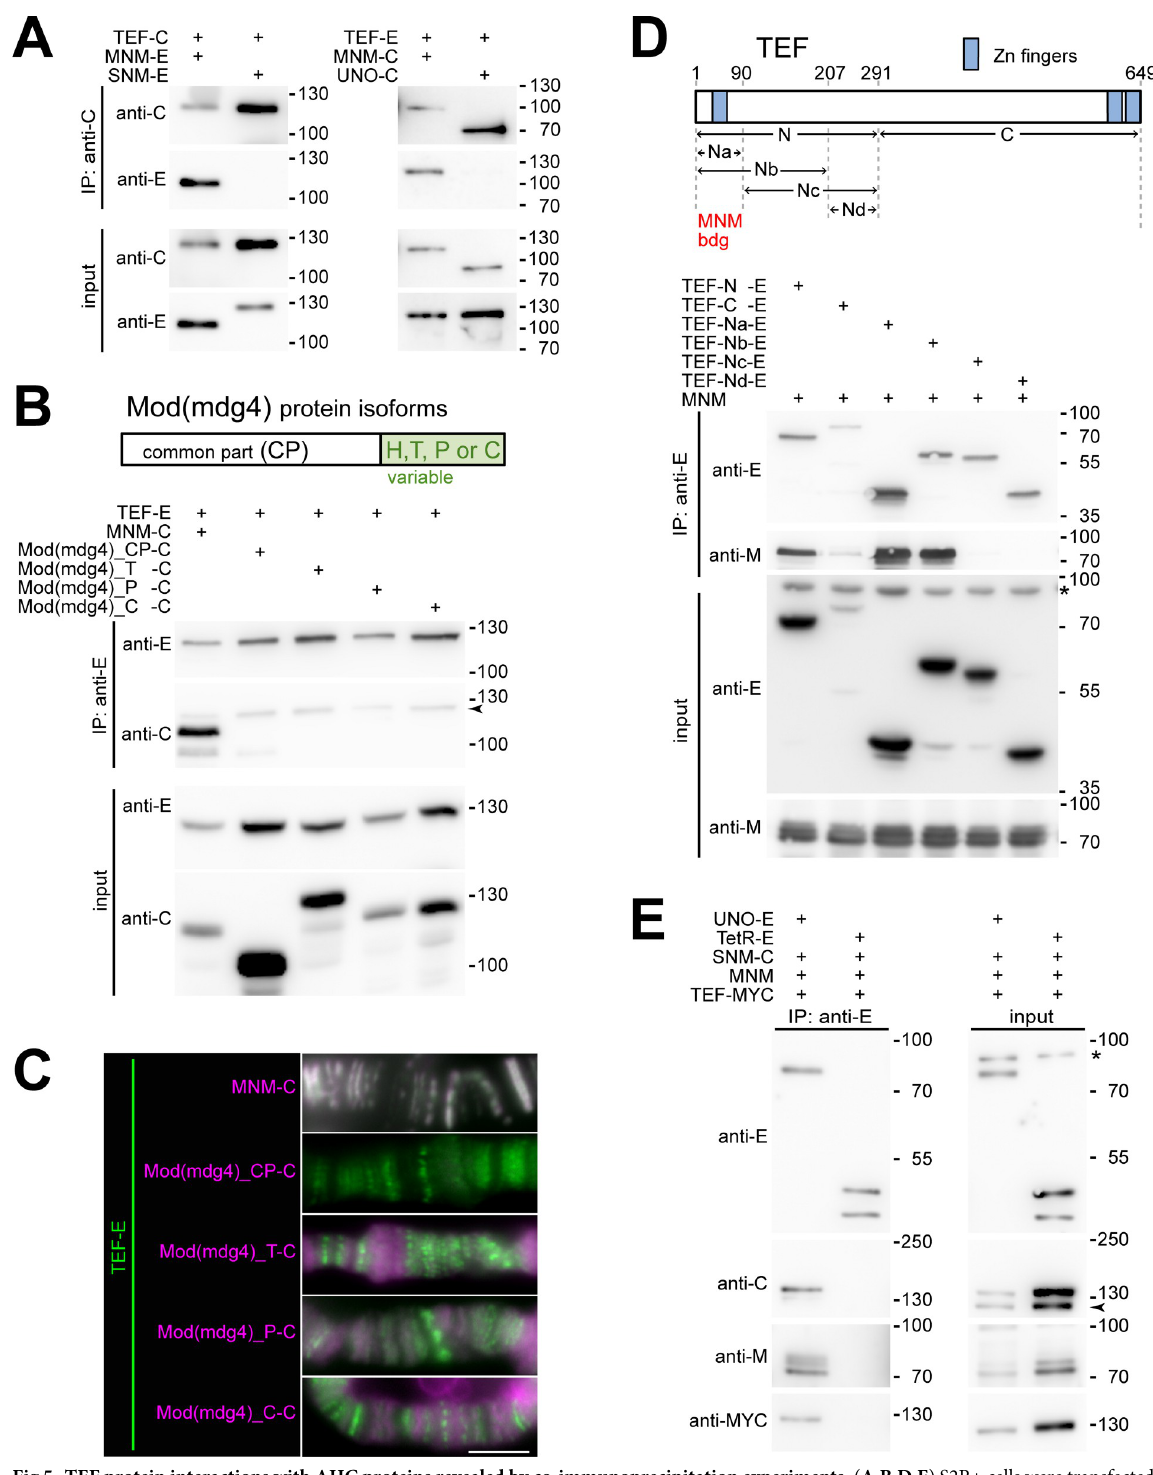
Fig 5. TEF protein interactions with AHC proteins revealed by co-immunoprecipitation experiments. ( A,B,D,E ) S2R+ cells were transfected for transient co-expression of AHC proteins, Mod(mdg4) protein isoforms and nls-tetracycline-repressor (TetR) for control as indicated. The expressed proteins were tagged with either EGFP (-E), mCherry (-C), myc epitope (-MYC) or untagged. After extract preparation, antibodies against EGFP (anti-E) or mCherry (anti-C) were used for immunoprecipitation. Input extracts and immunoprecipitated proteins were analyzed by immunoblotting with anti-E, anti-C, anti-MYC and anti-M, an antibody against the region present in all Mod(mdg4) protein isoforms